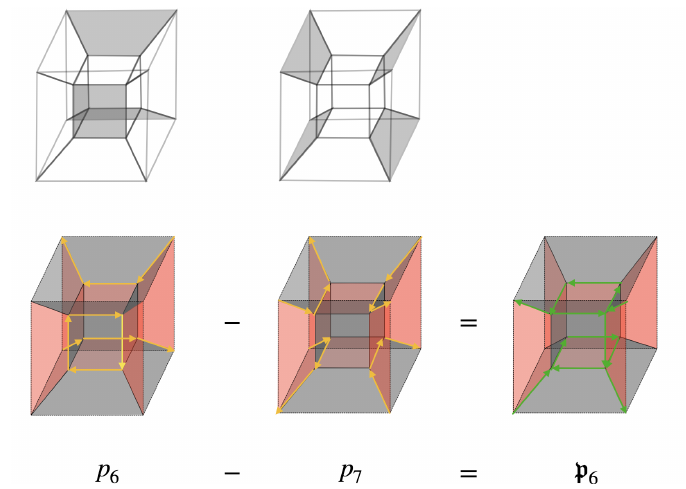
Figure 22 . Flow p 6 associated to the perfect matching p 6 , using p 7 as the reference perfect matching.